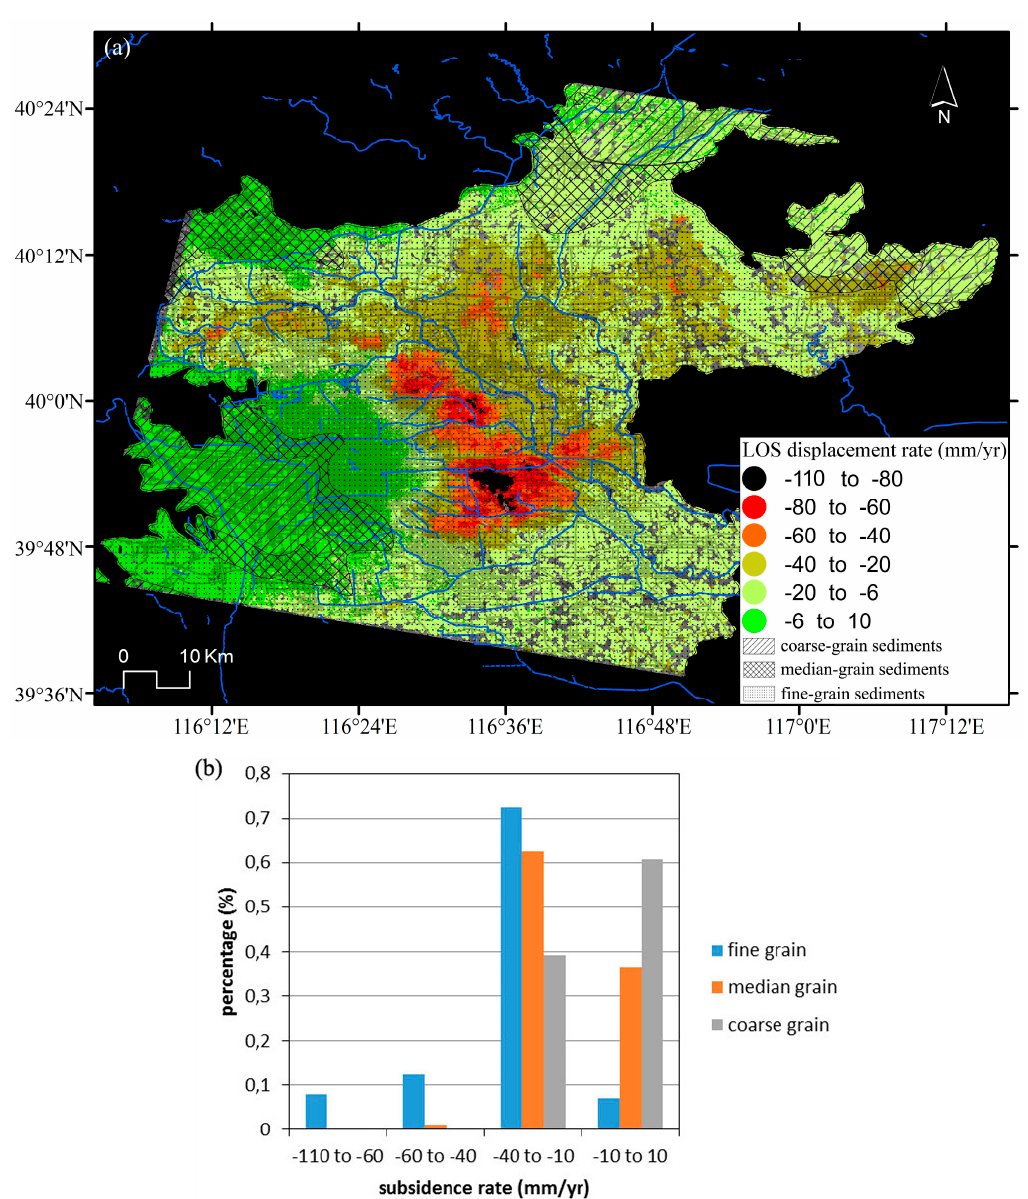
Figure 12. ( a ) Distribution and ( b ) statistics of InSAR derived data for the different types of aquifers.